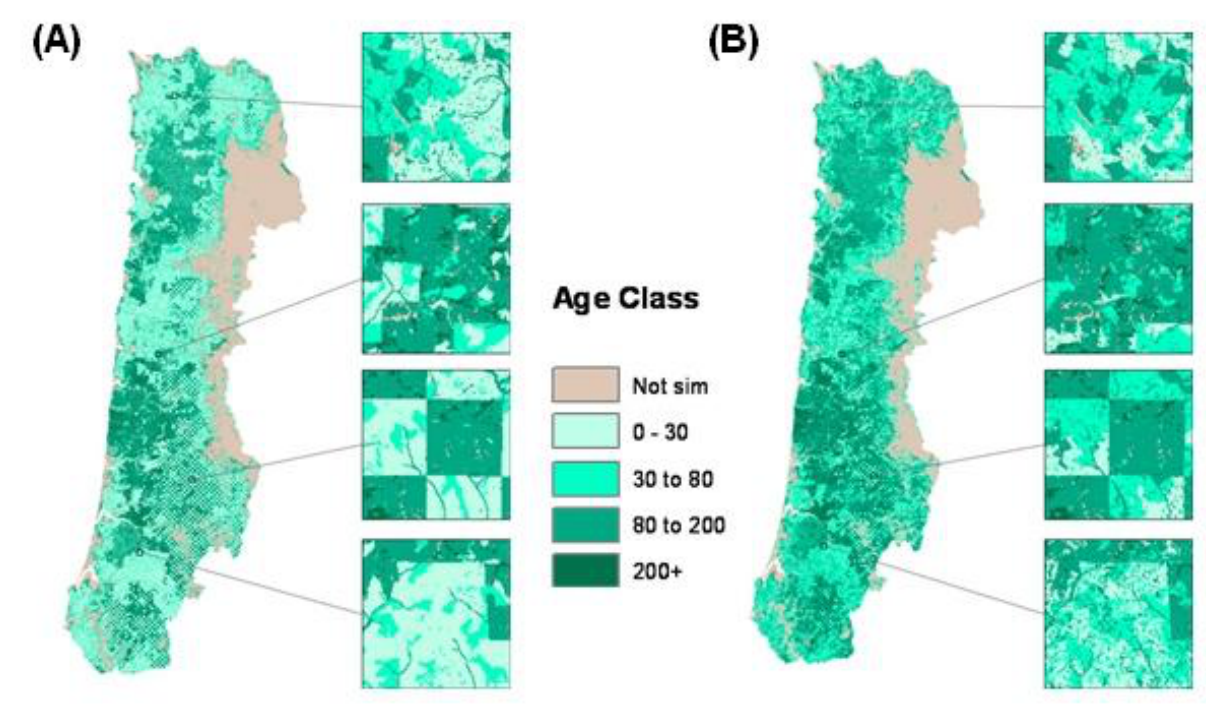
Fig. 2. One-hundred-year simulations of forest growth and management using (A) current policy and (B) a disturbance-based approach using the HRV as a reference. There is a greater distinction of age classes along the square ownership blocks separating private and public lands under the current policy scenario than under the disturbance-based